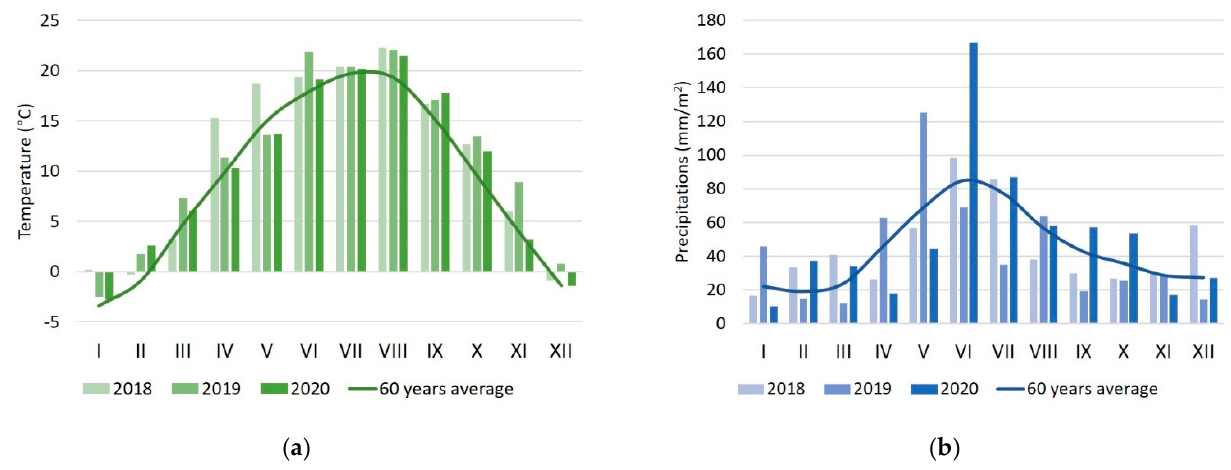
Figure 1. Weather conditions during the experiment (2018–2020), ( a ) average monthly temperatures; ( b ) monthly sum of precipitations; according to ARDS Turda weather station situated at longitude 23°47 ′ , latitude 46°35 ′ altitude 427 m.